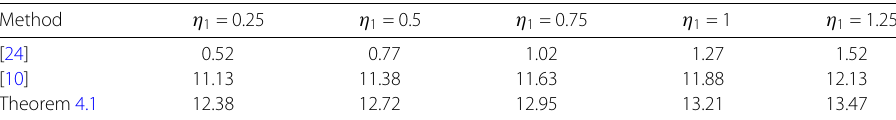
Table 3 MAUBs of η 2 for various values of η 1 ( μ 1 = 0.125, μ 2 = 0.25) Method η 1 = 0.25 η 1 = 0.5 [24]